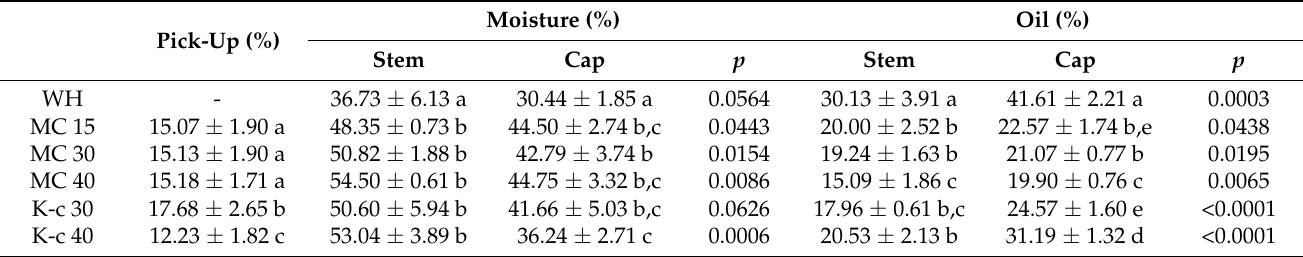
Table 5. Differences in the pick-up, moisture, and final oil content of samples prepared with different edible coatings, after frying at 170 ◦ C for 150 s.